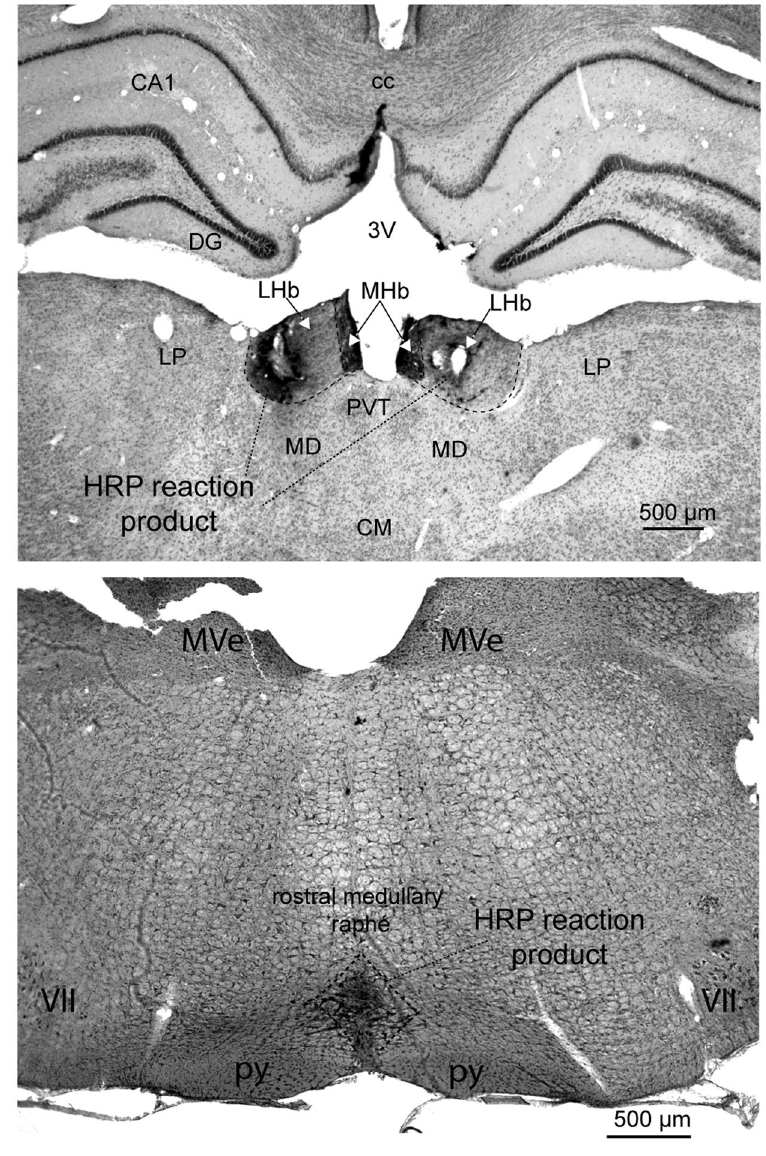
Figure 4. Histological demonstration of microinjection sites into the LHb (top) or into the medullary raphé (bottom). The sites were marked by horseradish peroxidase (HRP) reaction product. Top : CA1, field CA of hippocampus; cc, corpus callosum; CM, central medial thalamic nucleus; DG, dentate gyrus; LHb, lateral habenula; LP, lateral posterior thalamic nucleus; MD, mediodorsal thalamic nucleus; MHb, medial habenula; PVT, paraventricular thalamic nucleus. Bottom: MVe, medial vestibular nucleus; py, pyramidal tract; VII, facial